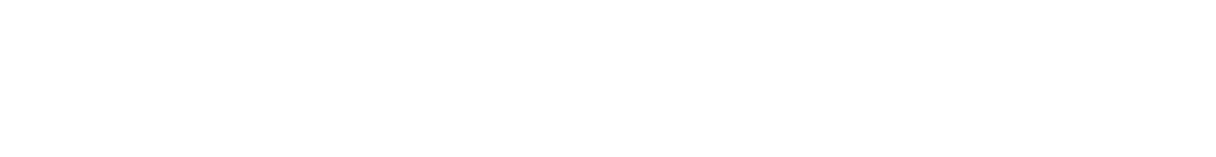
Frontiers in Microbiology | Aquatic Microbiology July 2012 |Volume 3 | Article 252 |